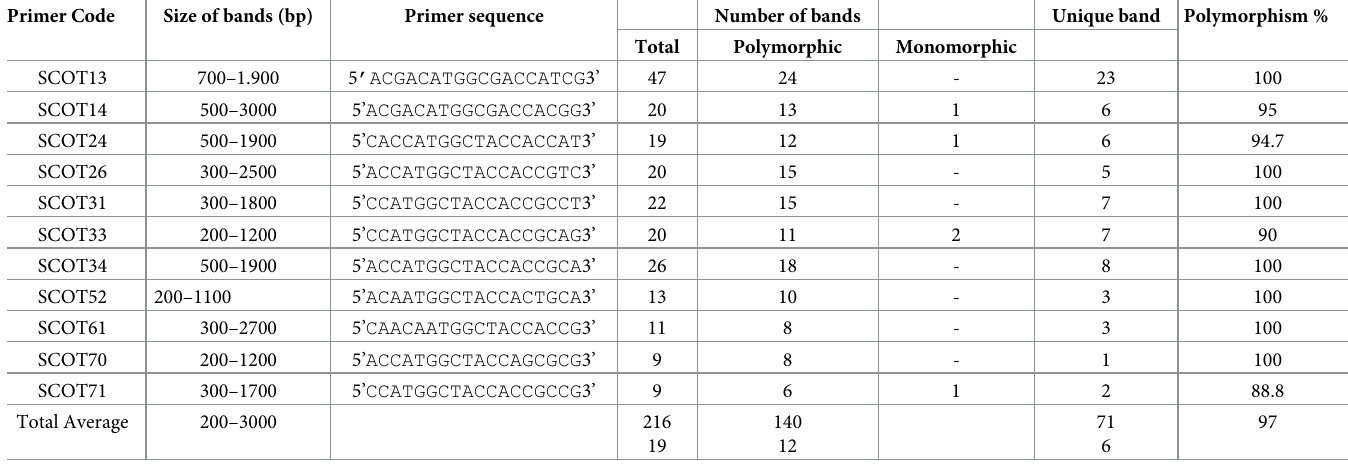
Table 7. Primer code, Size of bands, primer sequence, percentage of polymorphism, total polymorphic and unique bands in the profile of SCoT primer. Primer Code